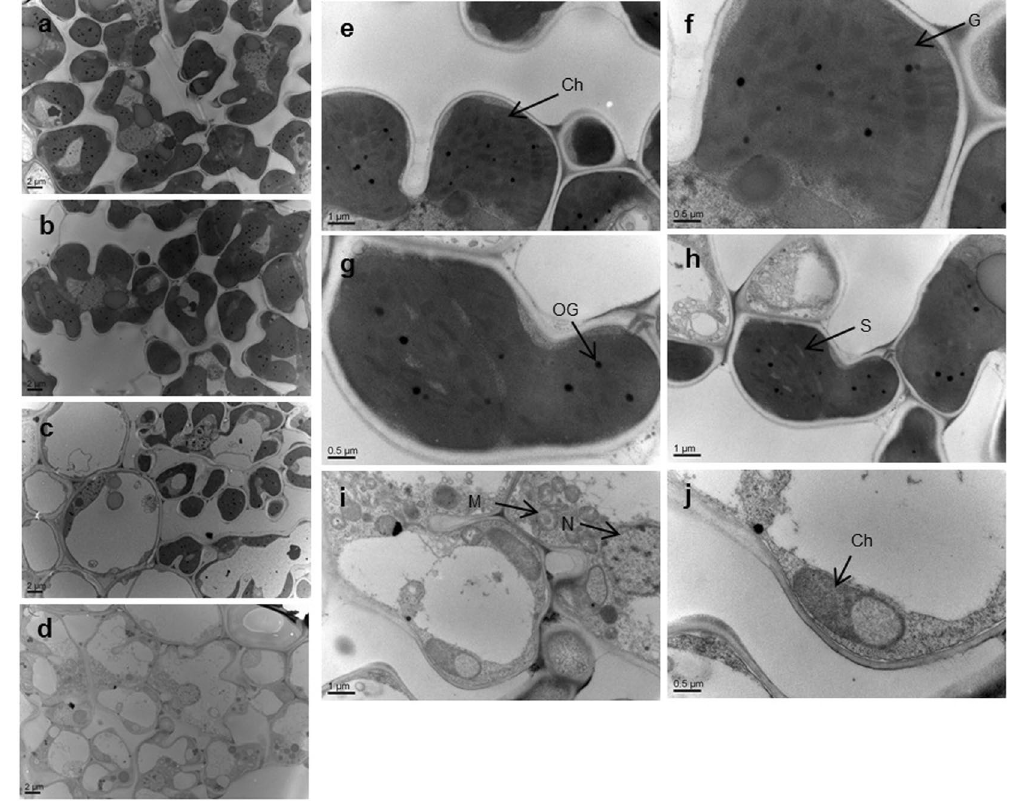
Figure 2. Leaf morphology and transmission electron microscopic images of chloroplasts of wild type and wfsl1 . ( a ) Wild type. ( b ) Green leaf sectors of wfsl1 . ( c ) Green and white leaf sectors of wfsl1 . ( d ) White leaf sectors of wfsl1 . ( e , f ) Wild type leaf sectors chloroplast morphology at tillering stage. ( g , h ) Green and white leaf sectors of chloroplast morphology at tillering stage of wfsl1 . ( i , j ) White leaf sectors chloroplast morphology at tillering stage of wfsl1 .( Ch ) Chloroplast. ( G ) Grana. ( M ) Mitochondria. ( N ) Nucleus. ( OG ) Osmiophilic plastoglobuli. ( S ) Starch granule.